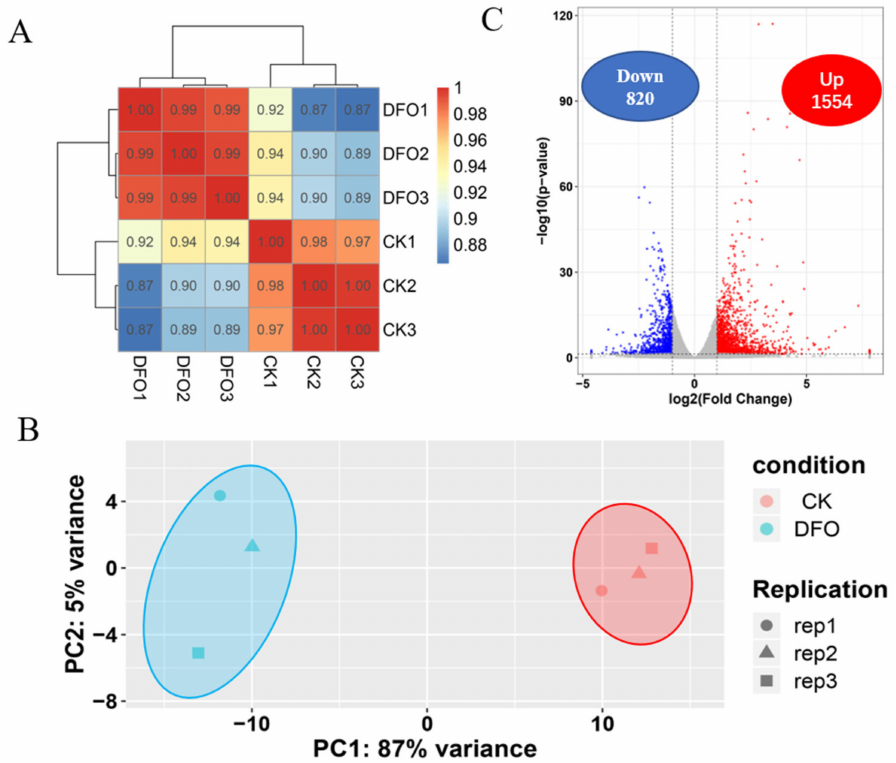
Figure 2. Global analysis of the transcriptome characteristics of C. camphora roots with and without deferoxamine. ( A ) Pearson distribution, ( B ) PCA diagram and ( C ) volcano plot.